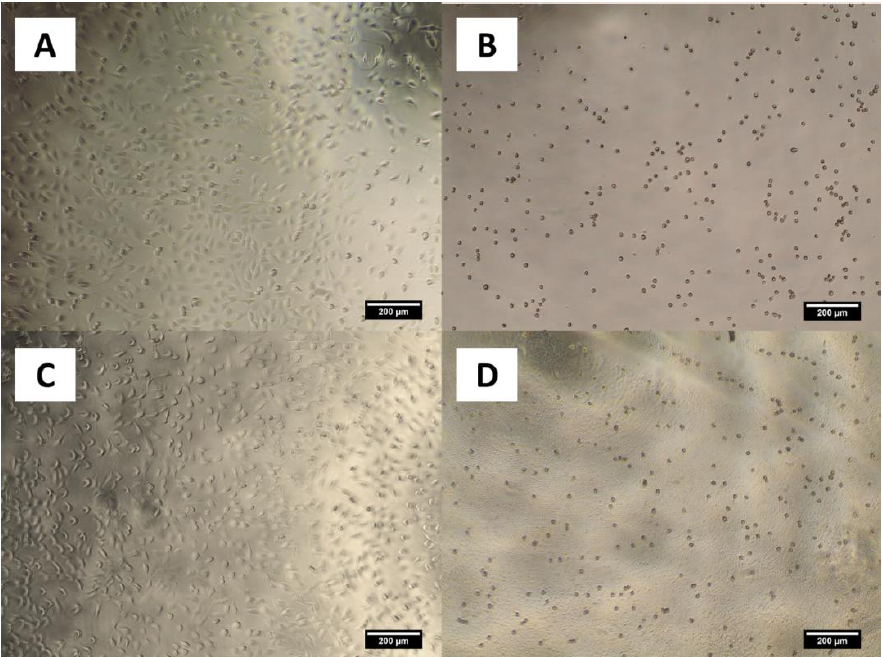
Figure 10. Images of T3T NIH cell adhesion on ( A ) well plate, ( B ) well plate with DMSO, ( C ) P(KA)/4-PEG hydrogel (4 wt%; 1:1 molar ratio) and ( D ) P(KA)/4-PEG hydrogel (4 wt%; 8:1 molar ratio) on light microscope (scale bar = 200 μm) .